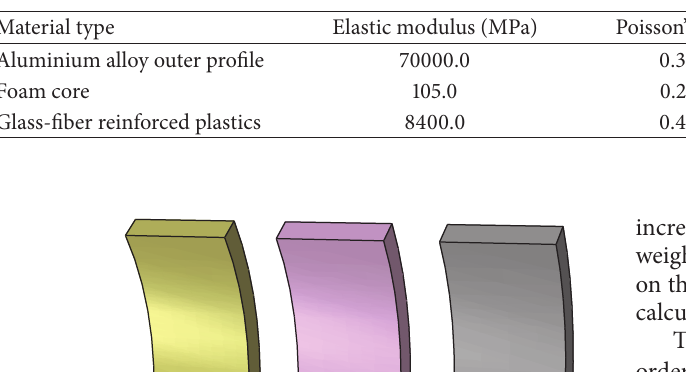
Table 4: Material properties for the train model [15].